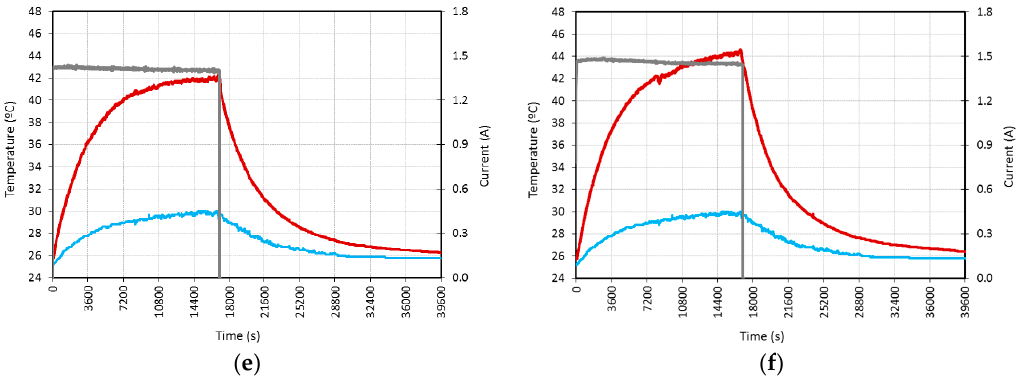
Figure 5. L.C. tests performed at different fixed voltages: ( a ) 10 V AC; ( b ) 10 V DC; ( c ) 20 V AC; ( d ) 20 V DC; ( e ) 25 V AC; ( f ) 25 V DC.